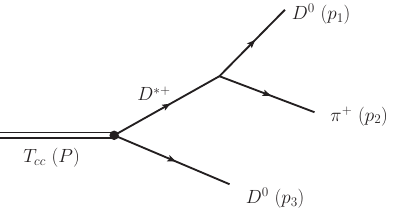
Figure 2. Mechanism for D 0 π + D 0 decay of the T cc state. The diagram with D ∗ 0 D + decay does not lead to final D 0 D 0 π + .